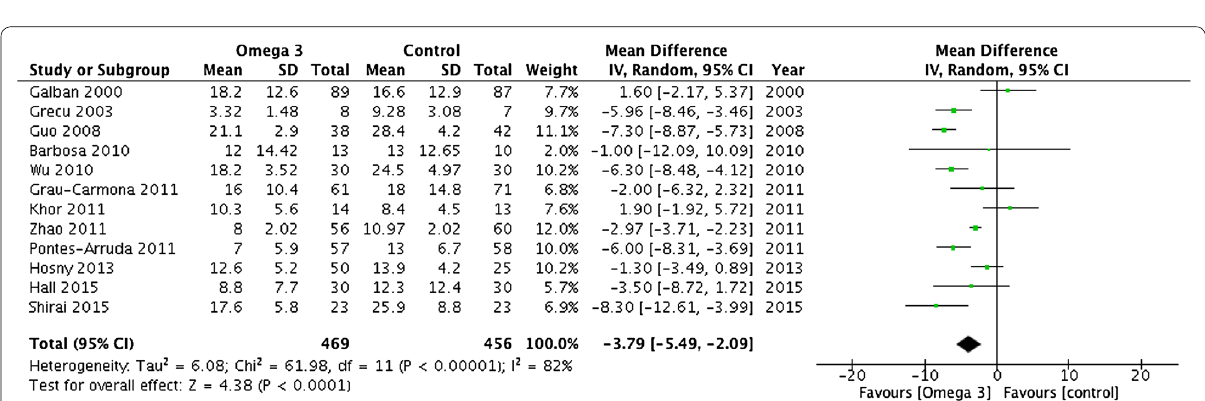
Fig. 4 ICU length of stay outcome. Data from 12 trials ( n 925 patients) were included and analysed using the random-effects model. Omega-3 = supplementation was associated with a significantly lower length of stay in ICU. IV inverse variance